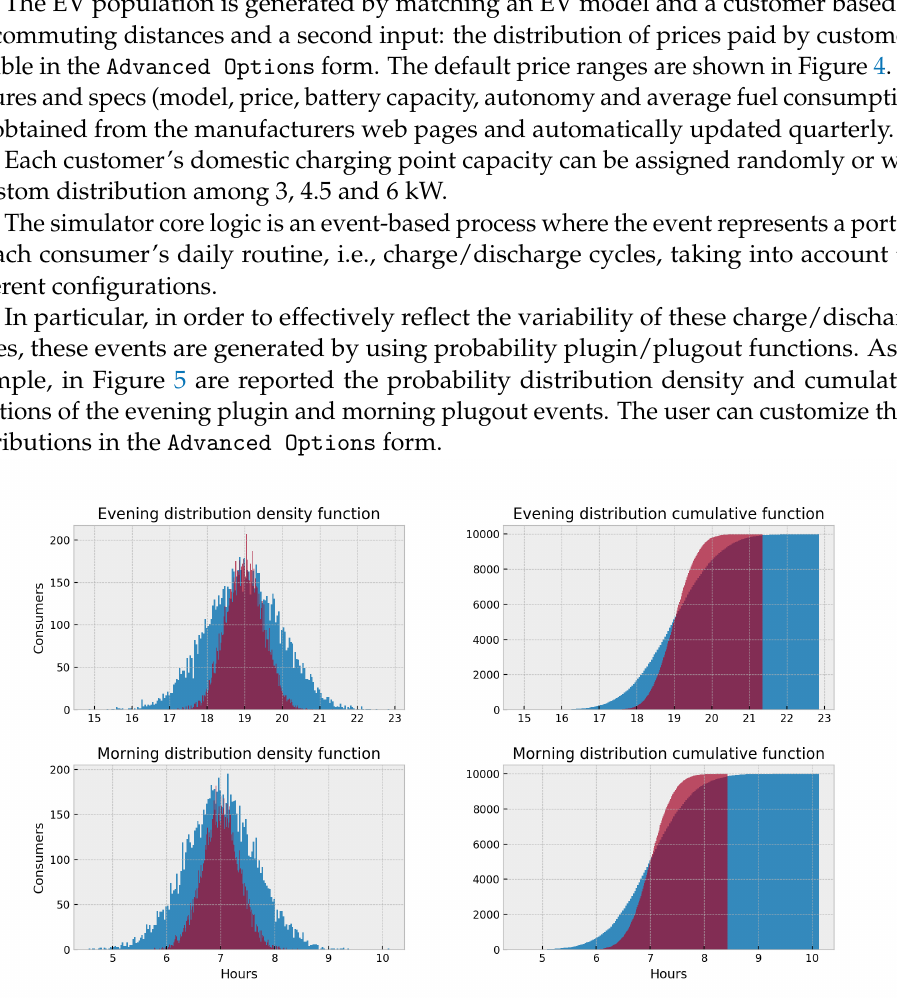
Figure 5. Morning and evening distribution density and cumulative functions relative to plugin events (first row) and plugout events (second row). The different curve colors highlight the possible user choices in order to determine different customers’